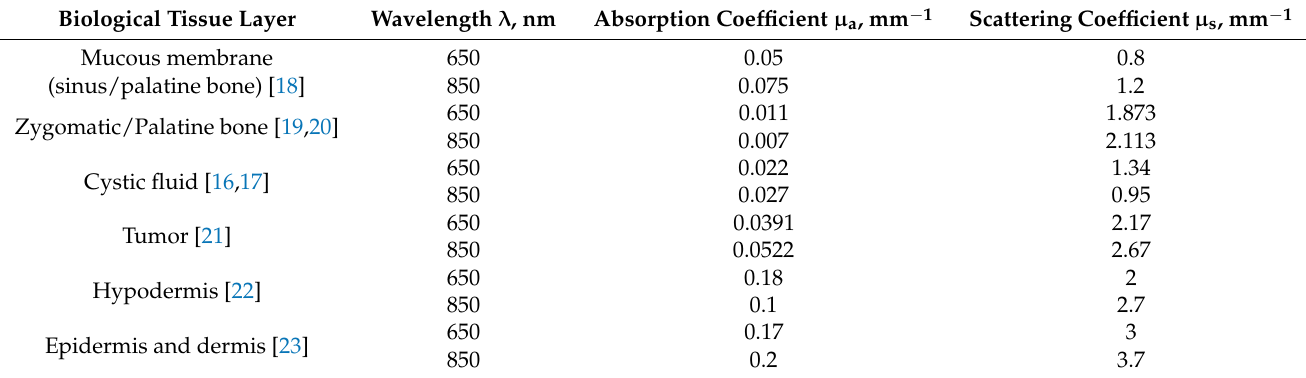
Table 1. The optical characteristics of biological tissues.